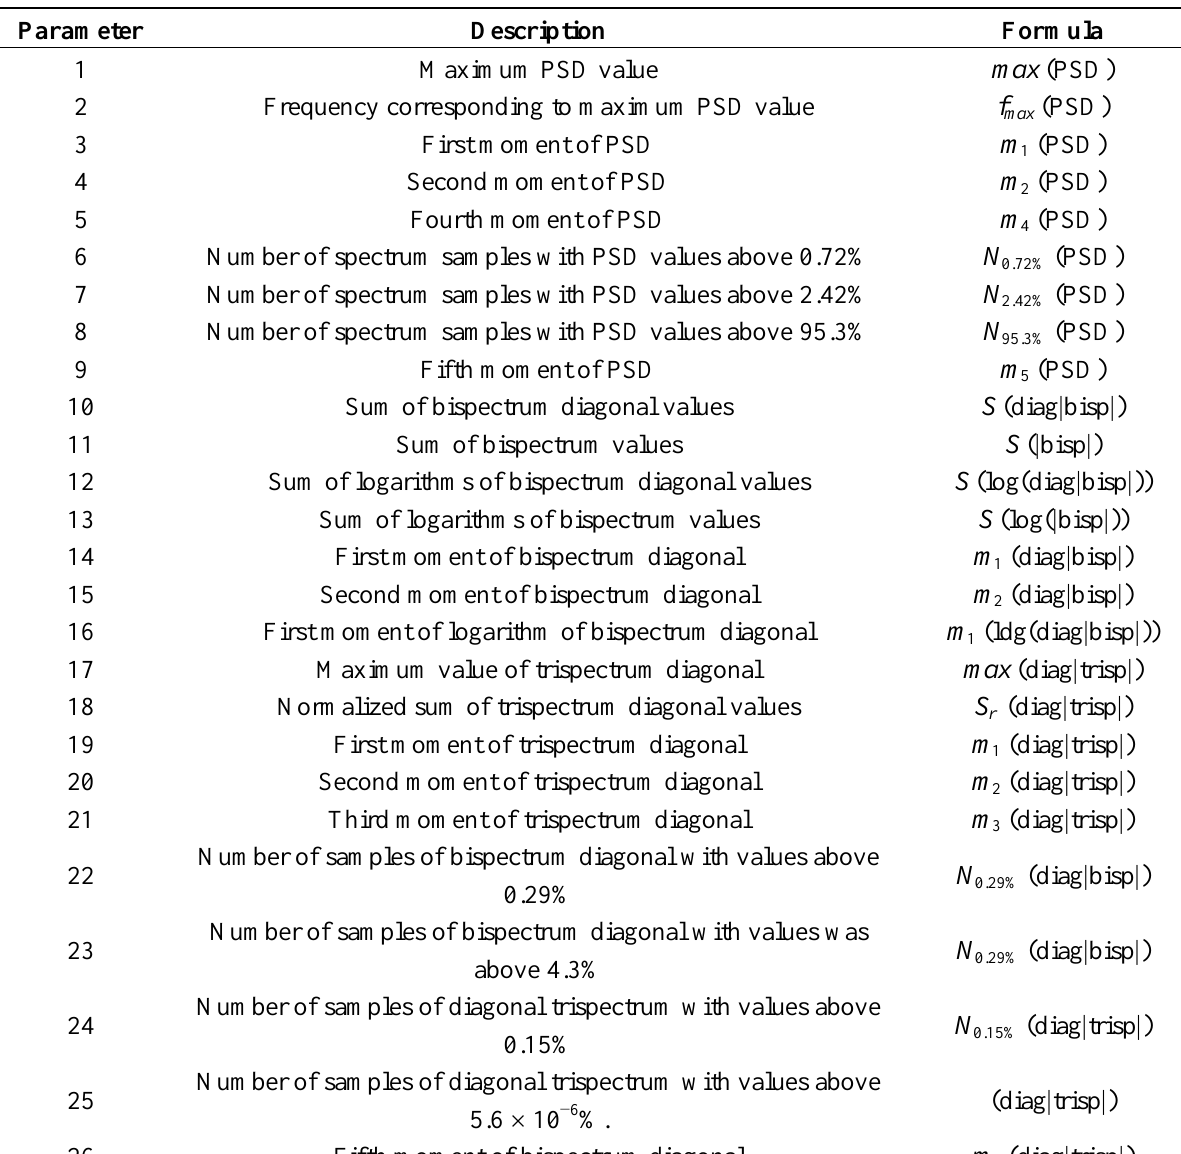
Table 3. List of 26 parameters obtained from each